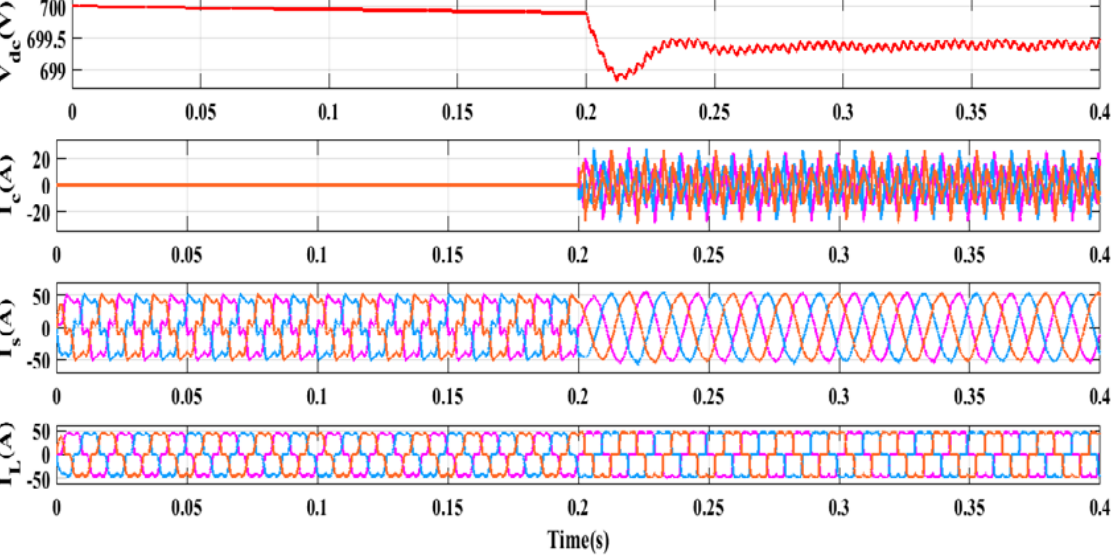
Figure 23. Performance of enhanced SRF SOGI-FLL-based DSTATCOM with electric arc furnace- based non-linear load . Figure 24 shows the comparative analysis of Icos 𝜽𝜽 and the proposed enhanced SRF SOGI-FLL controller with different non-linear loads. To visualize this figure, DC voltage regulations have been selected as 7 instead of 700 V. It has been also found that the pro- posed controller gives better features in terms of power factor improvement, THD [40], as well as DC voltage regulation.